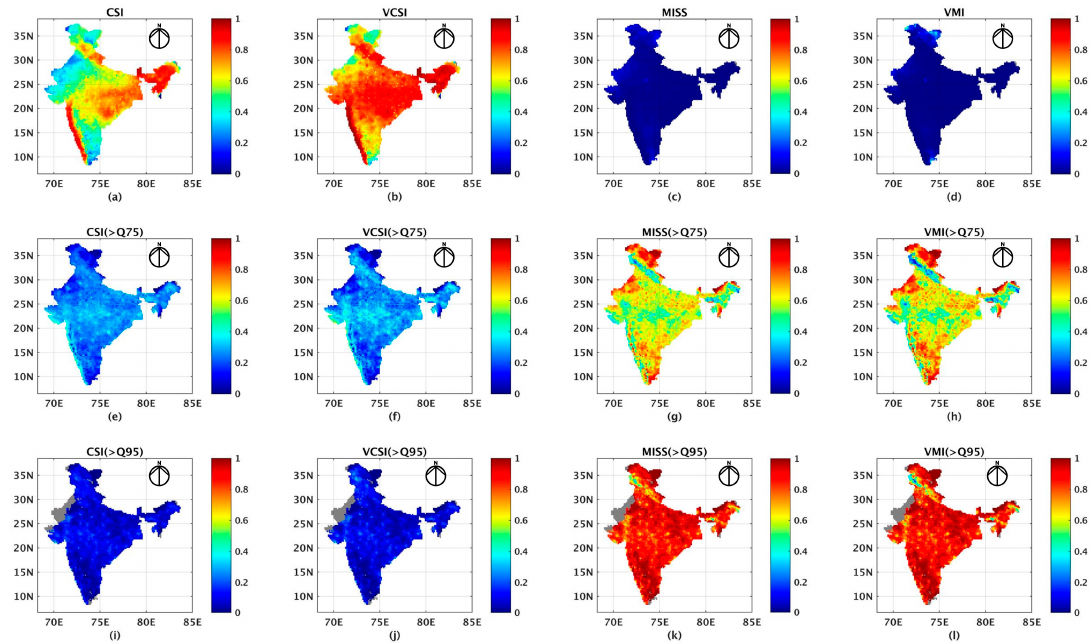
Figure 9. ( a – l ) Spatial distribution of categorical indices for the JJAS months over India for daily and higher quantiles of precipitation using MSWEP and IMD daily precipitation data from 1979 to 2013 showing CSI ( a , e , i ); VCSI ( b , f , j ); MISS ( c , g , k ); and VMI ( d , h , l ).